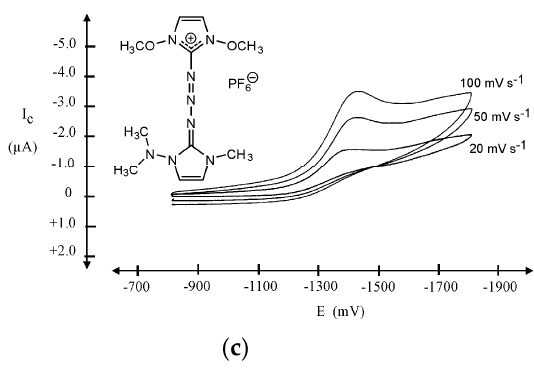
Figure 7. ( a – c ) Cyclic voltammograms of the triazenes 1 – 3 . Table 5. Cathodic peak potential ( E p ) c and cathodic peak current ( I p ) c of the triazenes 1 – 3 in CH 3 CN/0.1 M Bu 4 PF 6 as function of scan rate (potential values vs. ferrocene couple).